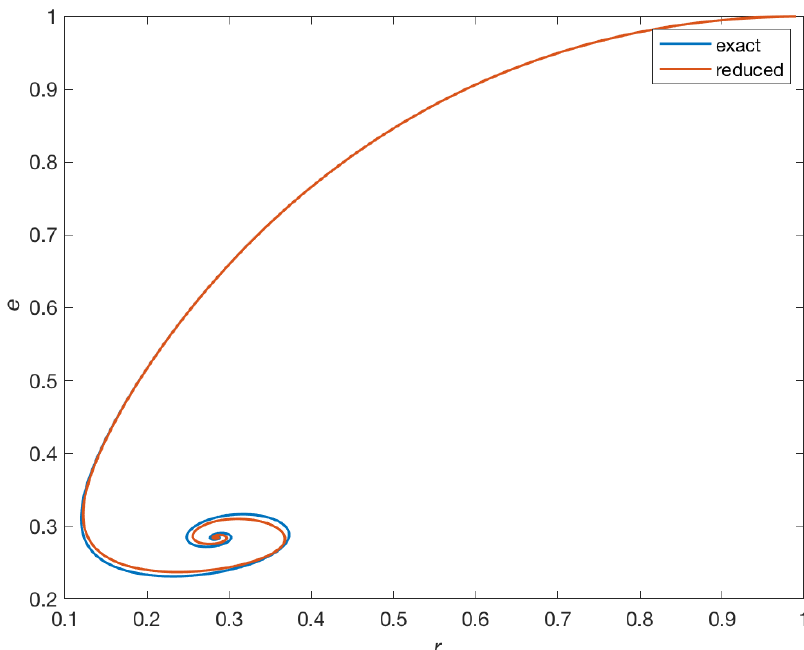
Figure 3. Comparison of the trajectories computed with the exact and reduced ODE models, systems (11) and (18) respectively, both started from an initial condition on the computed slow